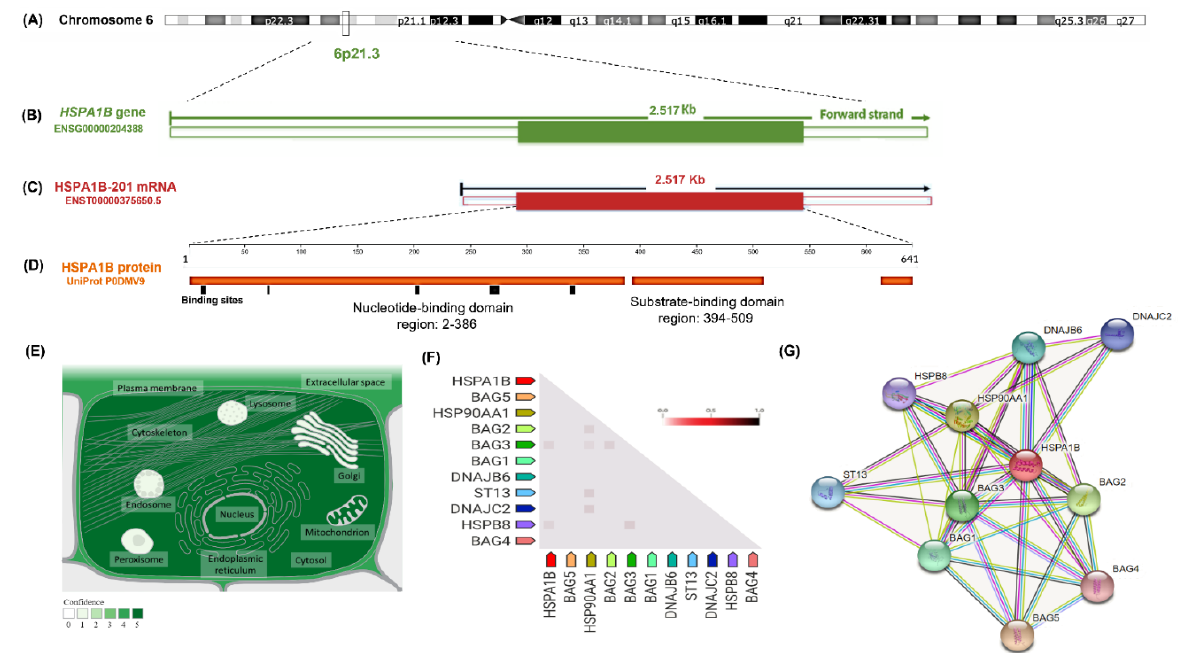
Figure 1. Structural features of heat shock protein family A (Hsp70) member 1B ( HSPA1B ) gene and protein. ( A ) The gene (Gene ID: 3304) encoding a 70 kDa protein, a member of the heat shock protein 70 family, is located on the short arm of chromosome 6 ‐ NC_000006.12. ( B ) The gene is 2517 bp long, spanning from position 31,827,738 to 31,830,254 ( Homo sapiens assembly; GRCh38.p14) along the forward strand. It consists of a single coding exon and lacks introns. ( C ) The gene has a single transcript of 2517 nucleotides, including the 5 (cid:48) - and 3 (cid:48) -untranslated regions (UTRs). ( D ) The encoded protein is a single polypeptide chain of 641 amino acid residues. The nucleotide-binding domains are shown in orange, and the binding sites are shown as small black boxes by which the protein goes through repeated cycles of ATP binding/hydrolysis and nucleotide exchange and release. ( E ) The subcellular localization of the HSPA1B. The degree of green darkness correlates with abundance. ( F ) The triangle matrix of the observed gene coexpression of HSPA1B in humans. The color intensity shows the confidence level of association, given the overall expression data in the organism. HSPA1B shows coexpression with the molecular chaperone regulator 3 (BAG3), which has anti-apoptotic activity and acts as “a nucleotide-exchange factor promoting the release of ADP from the HSP70, thereby triggering substrate release” (score = 0.985). In addition, HSPA1B is coexpressed with a high level of confidence with the heat shock protein β -8 (HSPB8), which displays “temperature-dependent chaperone activity” and belongs to the HSP20 family (score = 0.956). ( G ) A protein–protein interaction network illustrates the predicted functional partners of the